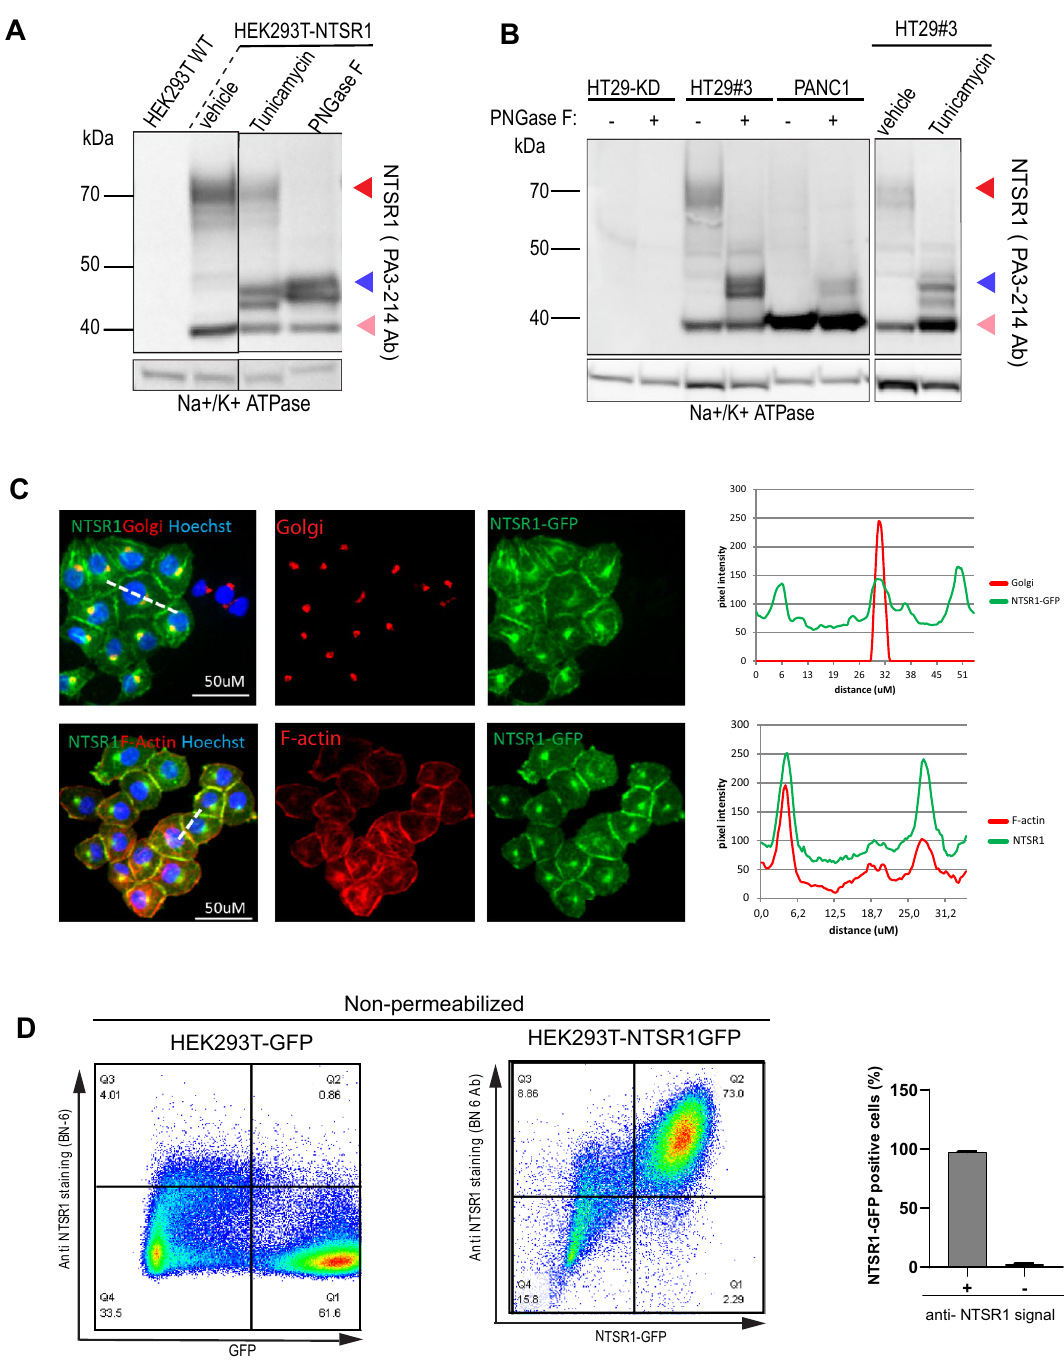
Figure 3. NTSR1 Glycosylation through the secretory pathway generates the proteins higher MW form. ( A , B ) Arrowheads: Red: NTSR1-high, pink: NTSR1-low, blue: NTSR1-LP. ( A ) Anti-NTSR1 WB performed on cell lysate from HEK293T cells overexpressing NTSR1 or not (WT). Cells were treated or not (untreated) with DMSO (vehicle) or with 2 µg/mL of the N-glycosylation inhibitor Tunicamycin for 24 h (tunicamycin) or untreated cell lysate was digested with the N-Glycosylase PNGase F (PNase F). Na + /K + ATPase is used as the loading control. ( B ) Representative anti-NTSR1 WB performed after SDS-PAGE of total GPCR fraction extracted from total membranes of HT29-KD (NTSR1-depleted by CRIPSR-cas9) or HT29#3 (HT29 isolated clone) were treated or not (untreated) with DMSO (vehicle) or with 2 µg/mL of the N-glycosylation inhibitor Tunicamycin for 24 h (tunicamycin) or untreated cell lysate was digested with the N-Glycosylase PNGase F (PNase F). HT29-KD is used as a negative control. Na + /K + ATPase is used as the loading control. ( C ) Representative confocal images of PANC1 cells overexpressing the C-terminal GFP-tagged NTSR1 protein. Cells were fixed and stained with anti-GM130 (Golgi), with Phalloidin (F-actin) and with Hoechst. GFP, Phalloidin and Golgi intensity were measured along the line scans applied on the images (dotted lines), and the pixels intensities values are presented. ( D ) FACS analysis of non-permeabilized HEK293T cells overexpressing the C-terminal GFP-tagged NTSR1 (NTSR1 GFP) construct or the GFP alone immunostained with an anti-NTSR1 antibody (BN-6). Right, quantification of GFP positive cells and anti-NTSR1 positive cells, + /- SEM, N = 3. Uncropped WB blots images are included in Supplementary